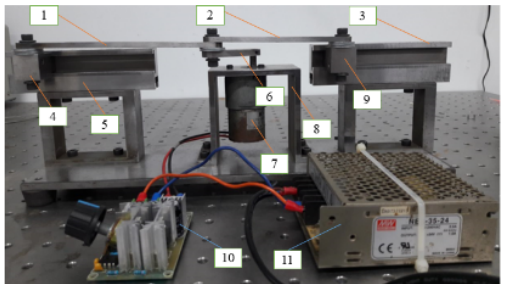
Fig. 1: Rigid Sider-crank